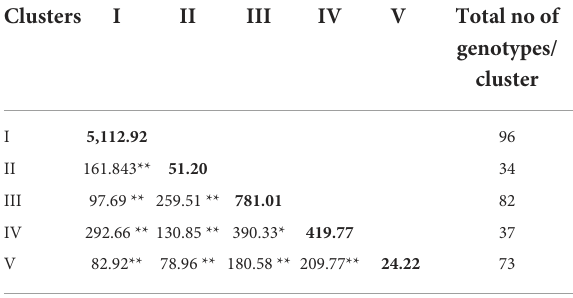
TABLE 5 Average intra cluster (bolded diagonal) and inter cluster (off-diagonal) distance (D 2 ) values. Clusters